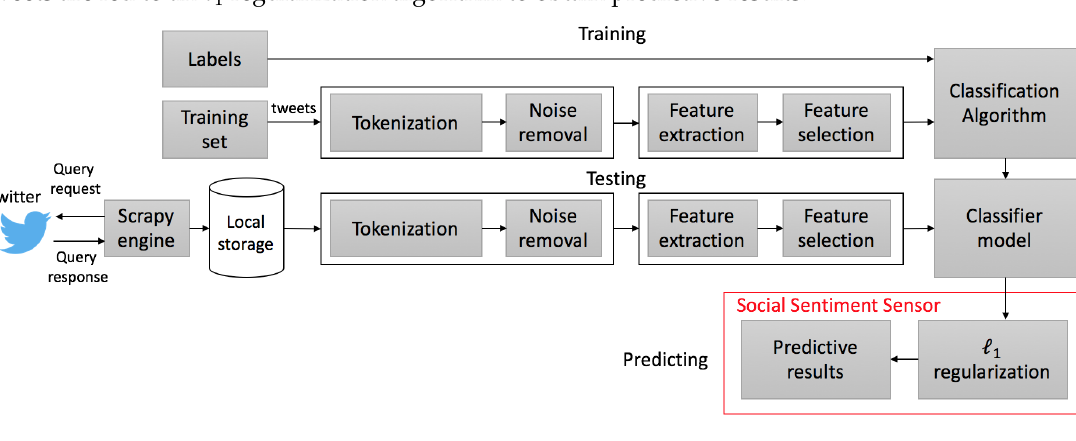
Figure 1. Work flow of the proposed methodology.